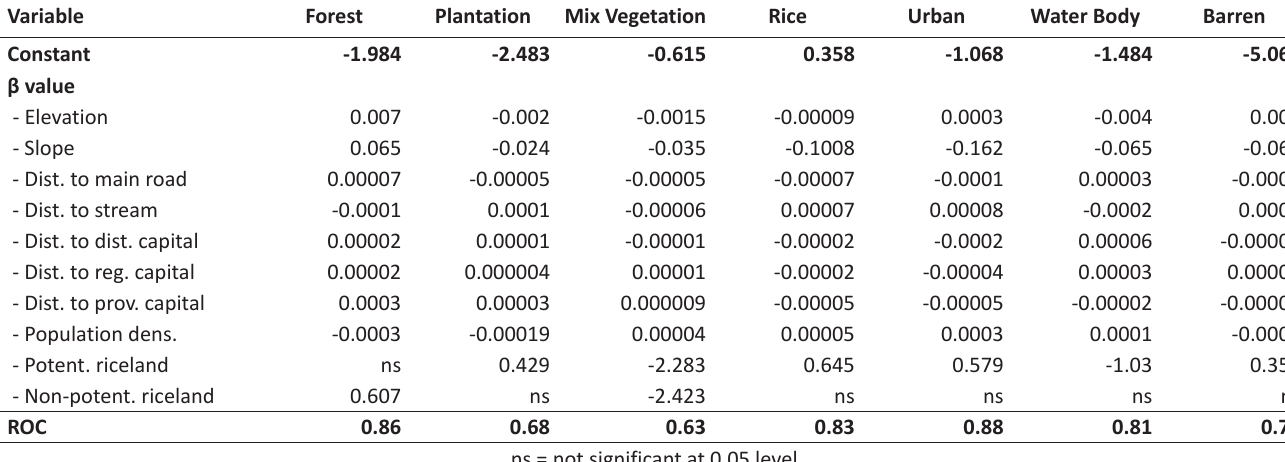
Table 4 . Coefficient of location factors of each landuse from binary logistic regression Variable Forest Plantation Mix Vegetation Rice Urban Water Body Barren